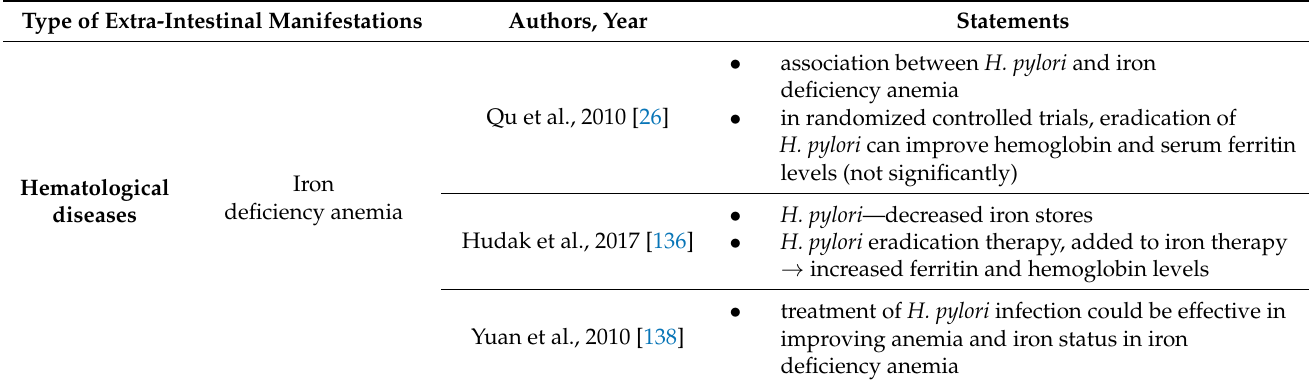
Table 2. Possible association between H. pylori and extra-gastrointestinal diseases—Meta-analysis- based